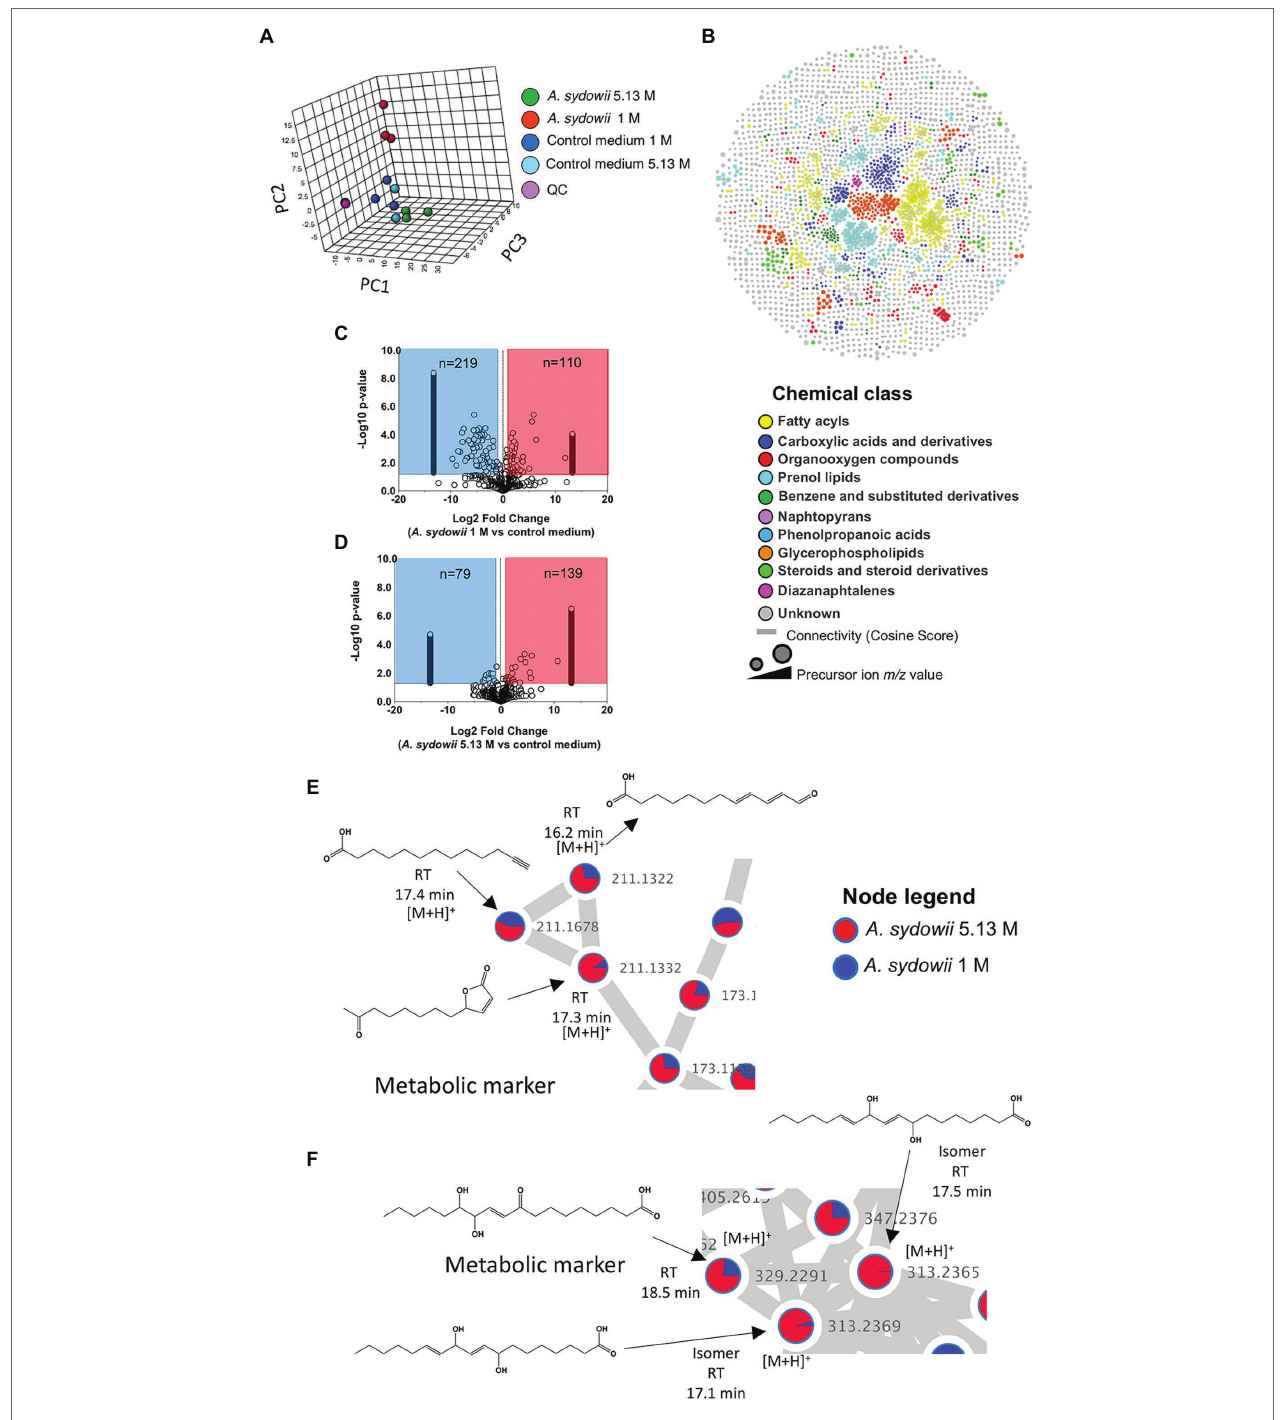
FIGURE 6 | Untargeted metabolomics and chemoinformatic analyses of A. sydowii EXF-12860 grown with either low 1 M NaCl or high 5.13 M NaCl concentrations. (A) 3D principal component analysis (PCA) displaying components 1 and 2 of features (abundance normalized) detected in 1 M and 5.13 M NaCl concentrations, including appropriate media controls. Quality control (QC) samples are displayed to assure the method reliability and stability. (B) Molecular classes (retrieved by Classyfire) of the metabolome identified by the MolNetEnhancer workflow and visualized using Cytoscape version 3.8.2. Each node represents a unique feature, and the color of the node denotes the associated chemical class. The thickness of the edge (connectivity) indicates the MS 2 similarity (Cosine score) among features. The m/z value of the feature is shown inside the node and is proportional to the size of the node. (C) Volcano plot showing the quantified features among 1 M NaCl media supernatant with and without A. sydowii . (D) Volcano plot showing the quantified features among 5.13 M NaCl media supernatant with and